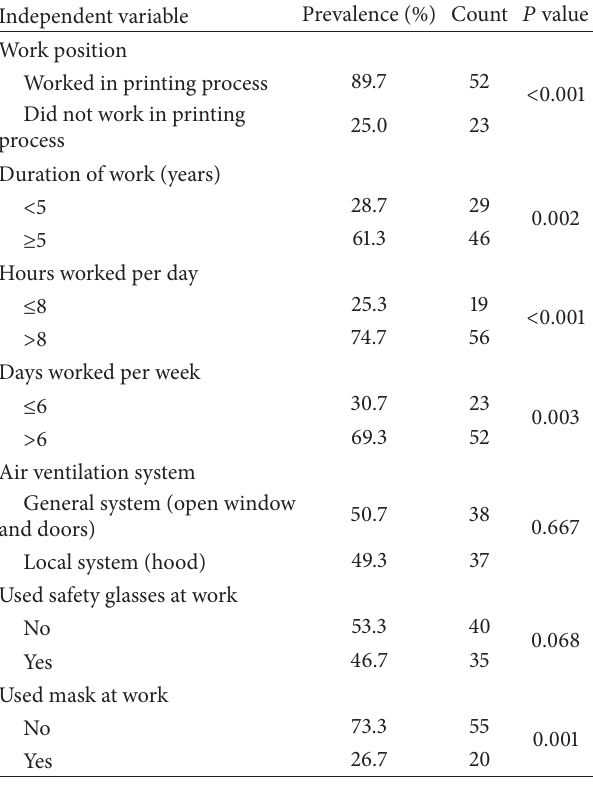
Table 5: Prevalence of rhinitis in the preceding 6 months, by independent variables: position worked, duration of work, hours worked per day, days worked per week, air ventilation system, and use of PPE.